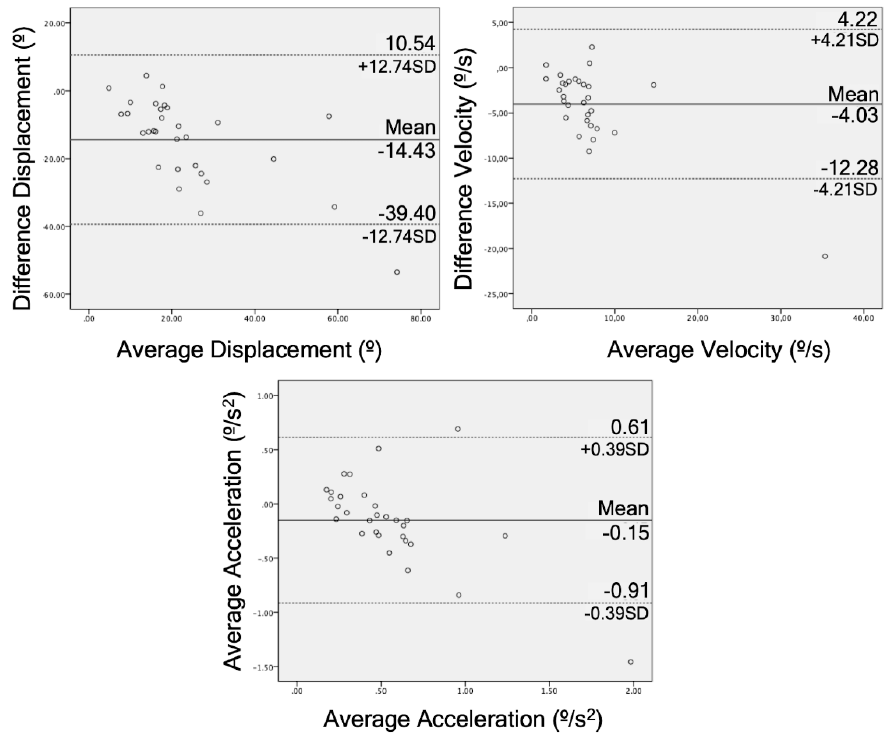
Figure 5. Bland–Altman plots for displacement, velocity, and acceleration in the STS test comparing the RGB-D camera and IMU. The lines represent the mean of the differences and limits of agreement.